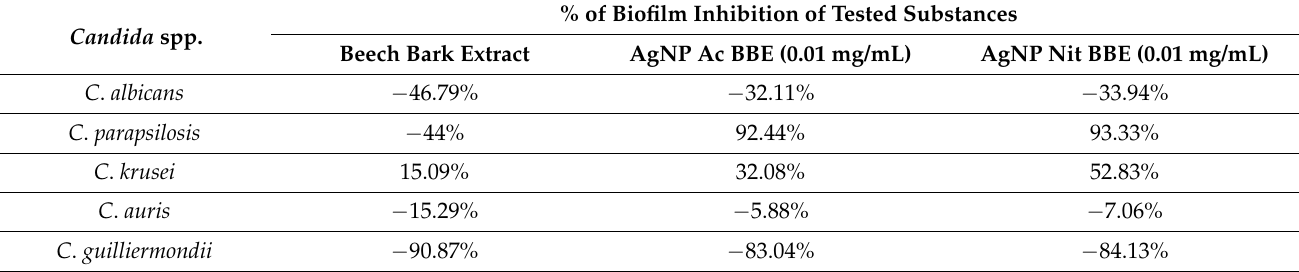
Table 2. The effect of tested solutions on biofilm formation.